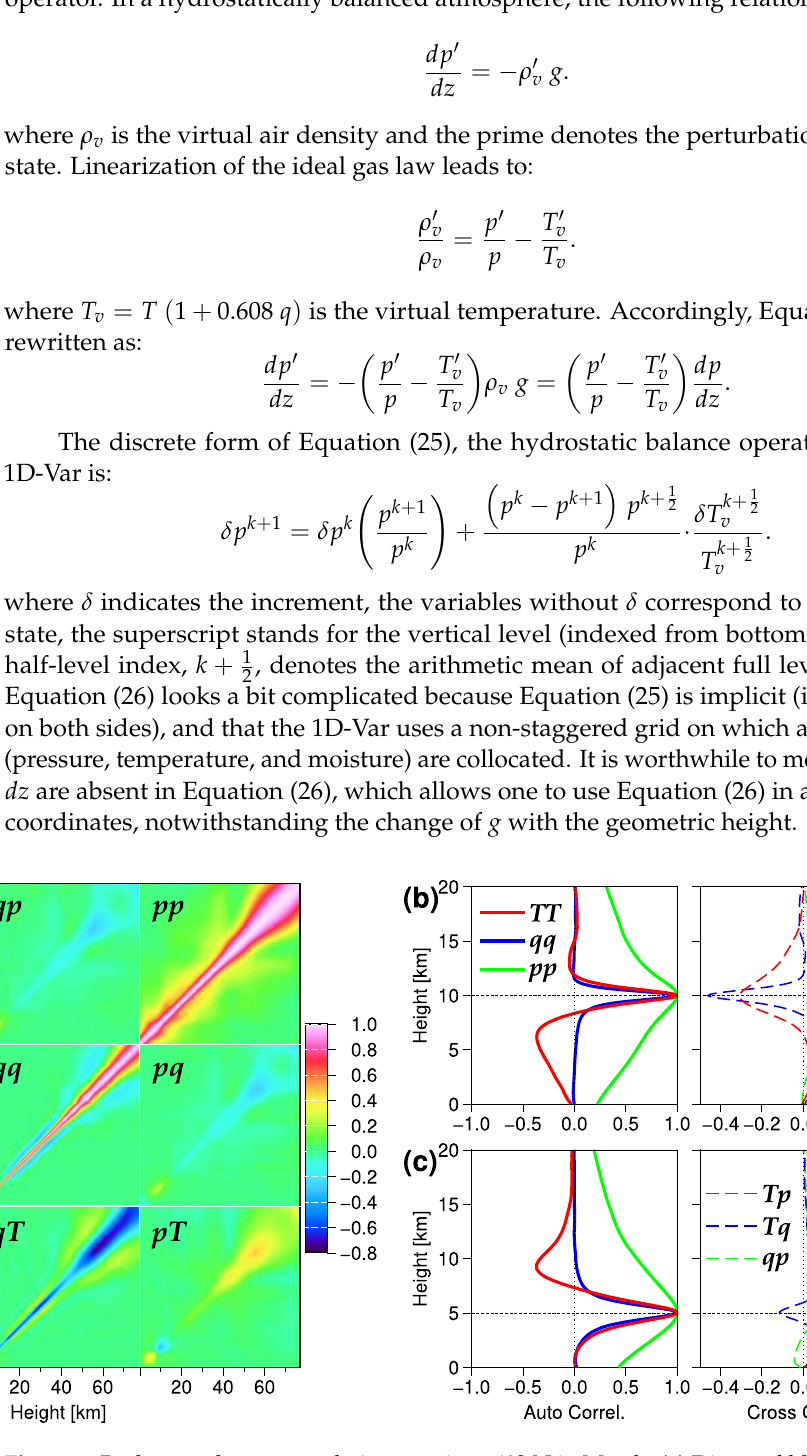
Figure 3. Background error correlation matrix at 60° N in March. ( a ) Diagonal blocks (lower left to upper right) show self-correlations of temperature (denoted T ), relative humidity ( q ), and pressure ( p ) errors, while off-diagonal blocks indicate cross-variable correlations. ( b ) Error correlations among the elements at 10 km and those at other heights. ( c ) Same as in ( b ) but for 5 km.